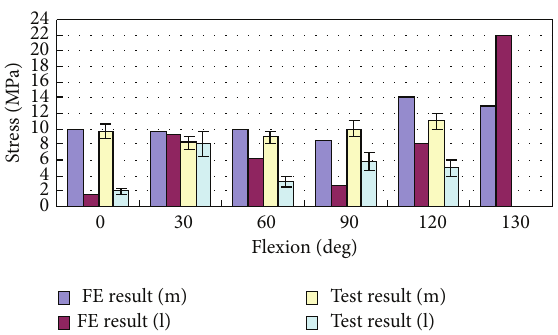
Figure 18: Comparison between experimentally measured stress applied to patella cartilage and the FE results, where m refers to the medial patella and l refers to the lateral